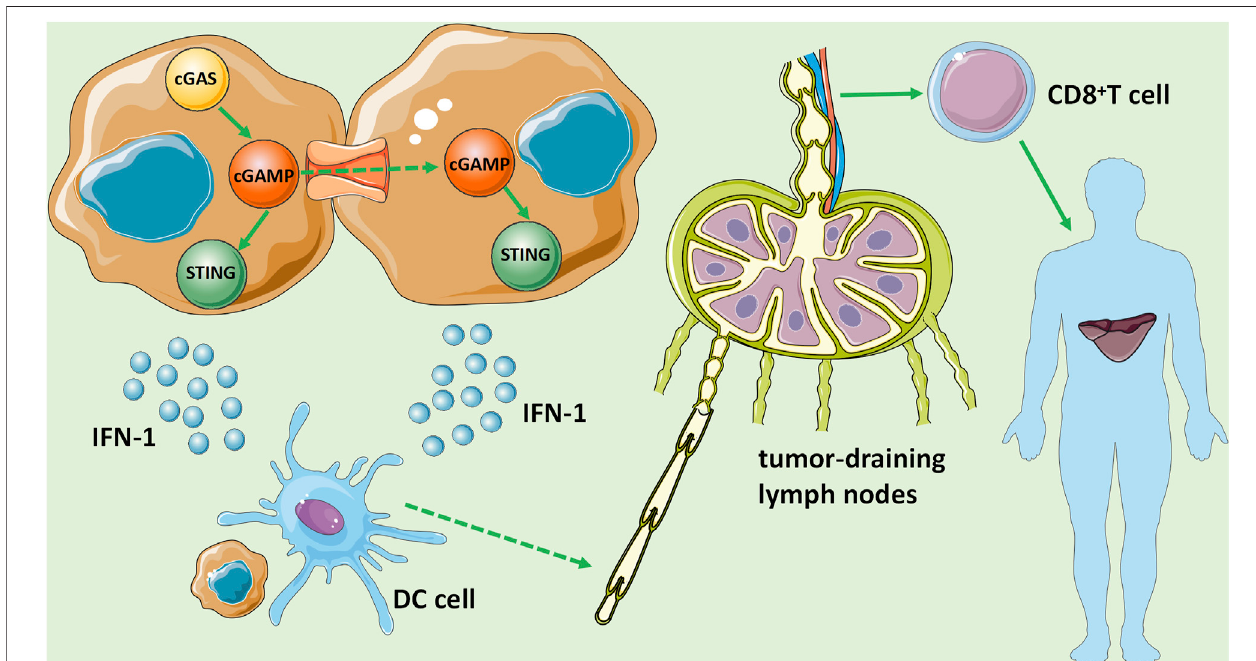
FIGURE3| TheroleofthecGAS-STINGsignalingpathwayinHCC.DNAdamageleadstotheformationofdsDNAinHCCcells,stimulatesandactivatesthecGAS- STINGsignalingpathway,andpromotesthereleaseofIFN-1,whichiscriticalforDCmaturation.Then,DCsmigratetotumor-draininglymphnodeswiththehelpofIFN-1 and cross-activate tumor-speci fi c CD8 + T cells, and induce systemic antitumor immunity to control local and distant metastasis of tumor growth.